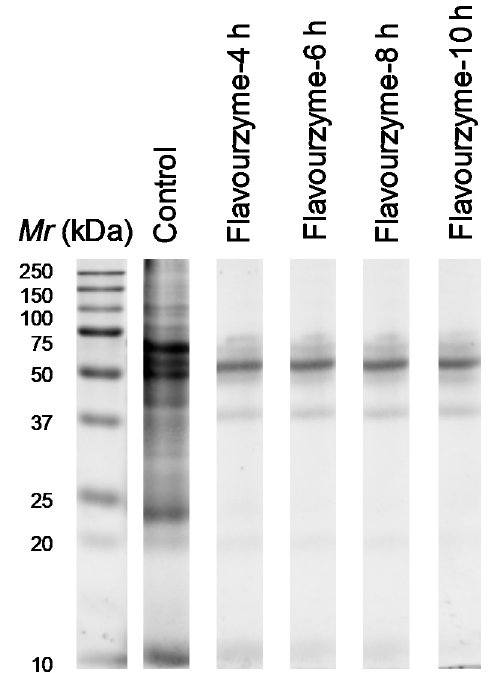
Figure 1. SDS-PAGE of proteins from control and pork liver hydrolysates obtained from Flavourzyme at di ff erent times of hydrolysis (4, 6, 8, and 10 h).